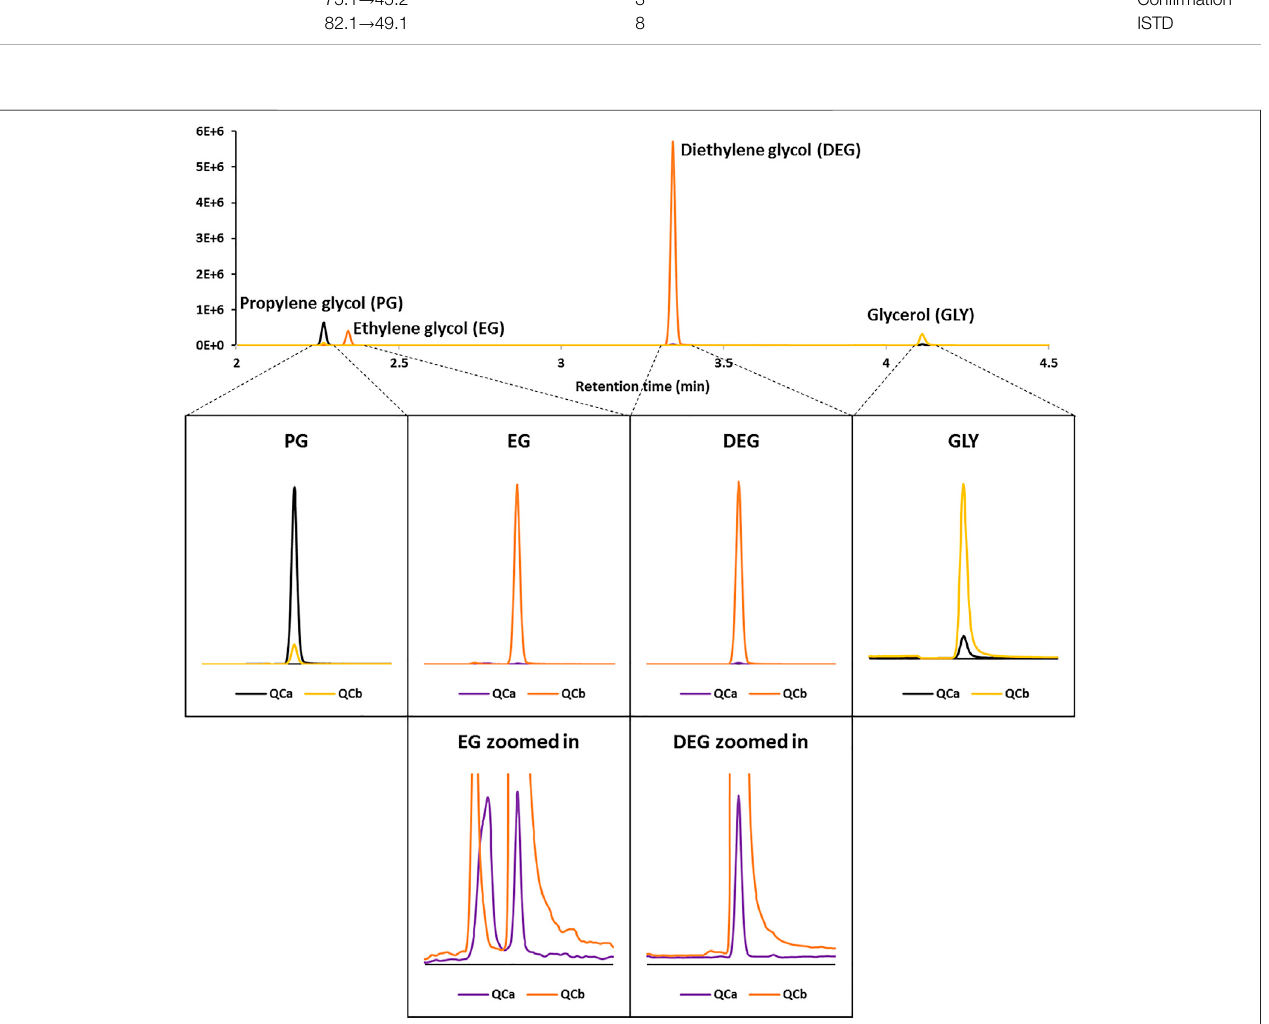
FIGURE 2 | Overlaid selected-reaction monitoring (SRM) chromatograms of the two QC levels.